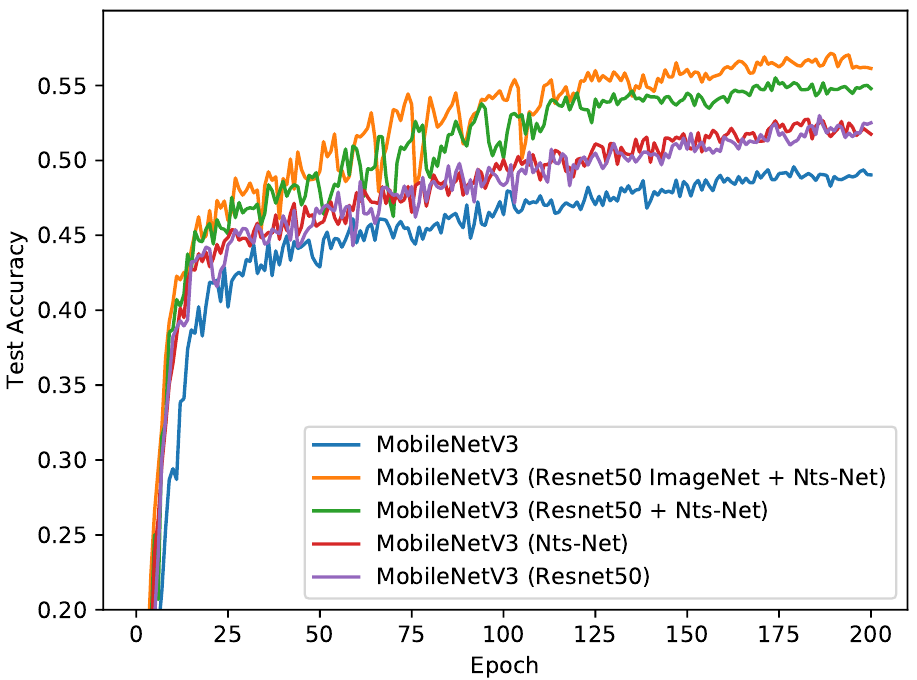
Figure 6. Test accuracy over the SOD dataset. The student network is a MobileNetv3. The teacher one is an NTS-NET. Teacher two is the ResNet50.